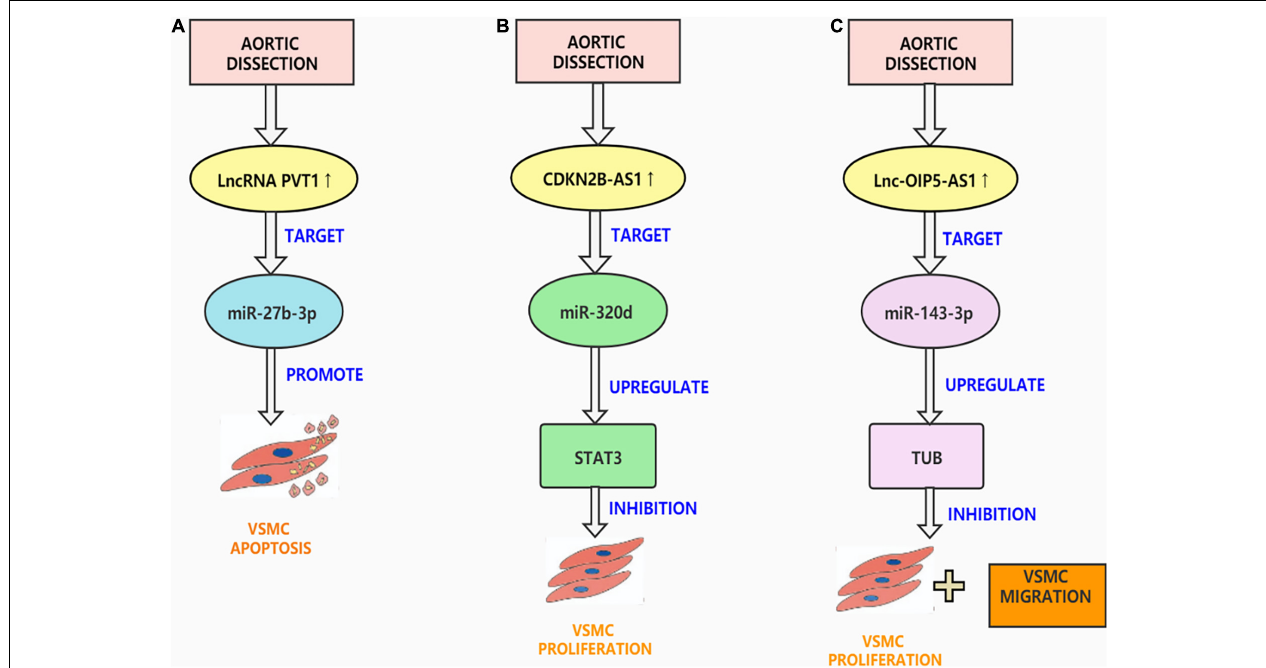
FIGURE 2 | Aortic dissection associated lncRNAs. (A) LncRNA PVT1 is up-regulated in AD tissues, targeting miR-27b-3p promotes VSMC apoptosis, inhibits VSMC viability, migration and phenotypic transformation. (B) CDKN2BAS1 enables STAT3 expression in VSMCs by competitively sponging miR-320d and thus controlling the multiplication and apoptosis of VSMCs. (C) OIP5-AS1 can bind to Mir-143-3p as a ceRNA and inhibit the proliferation and migration of HAECs and HASMCs.